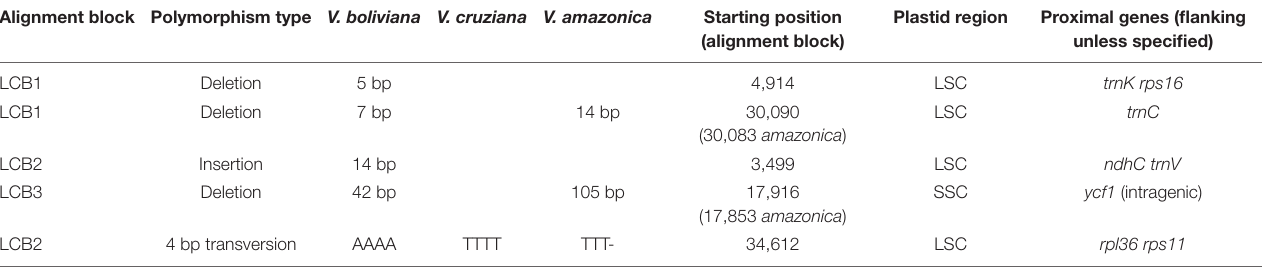
TABLE 3 | Plastid polymorphisms (other than point mutations) diagnostic for V. boliviana sp. nov. Alignment blocks are arbitrary units computed by Mauve v.2.3.1. Alignment block Polymorphism type V. boliviana V. cruziana V. amazonica Starting position